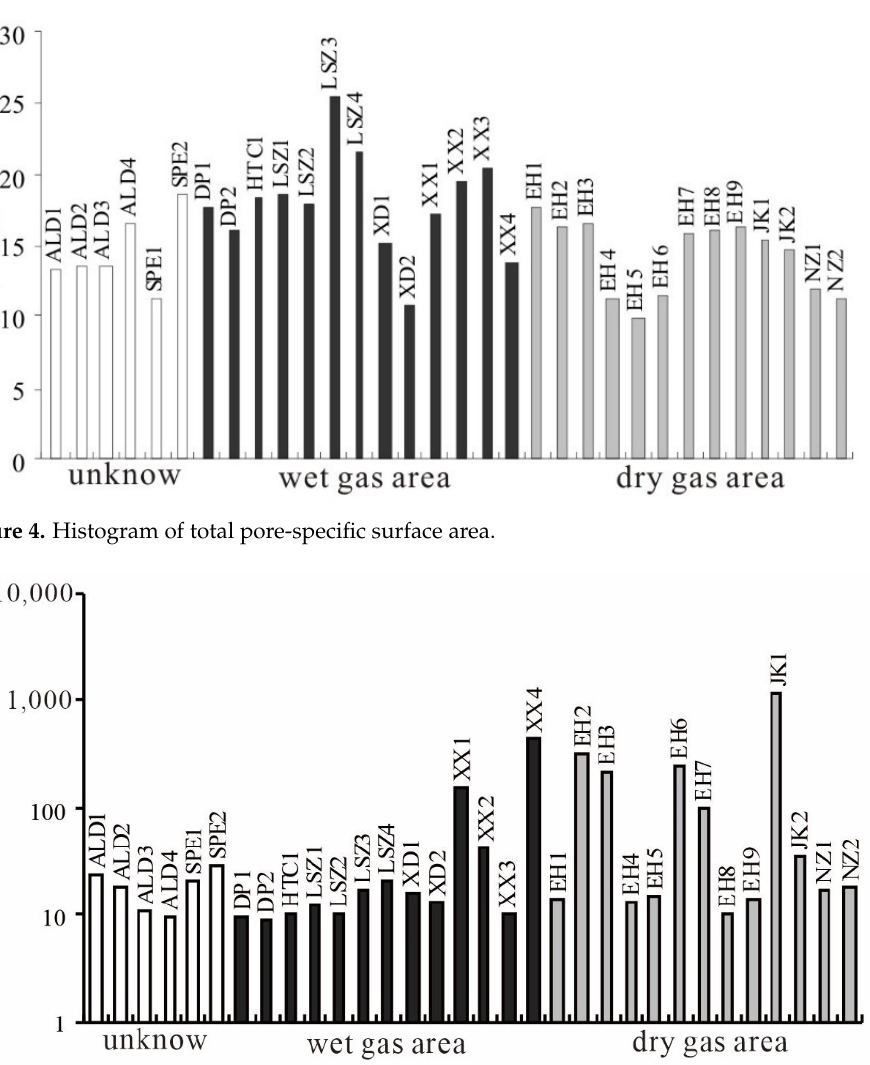
Figure 5. Histogram of median pore diameter.